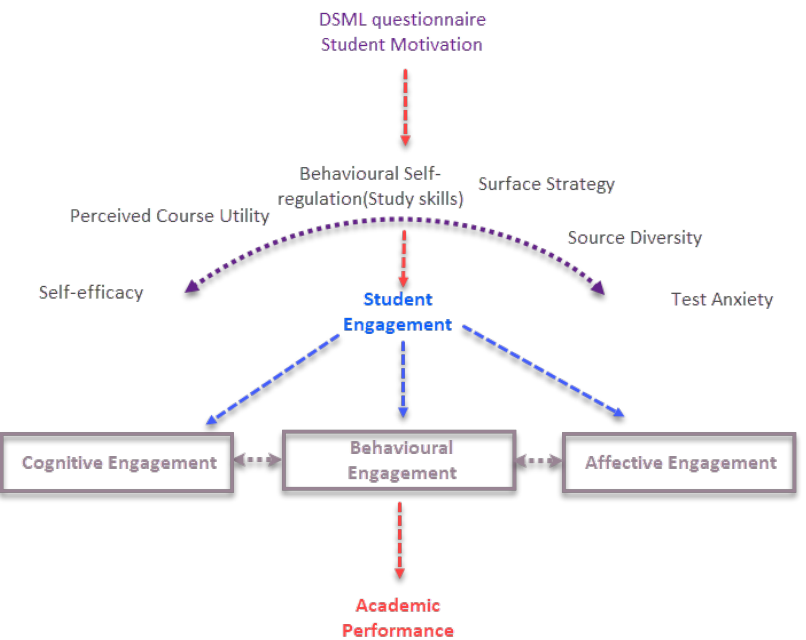
Figure 2. The six component elements of DSML are measuring the three dimensions of the student engagement framework that theoretically predict student engagement framework that theoretically predict student performance.